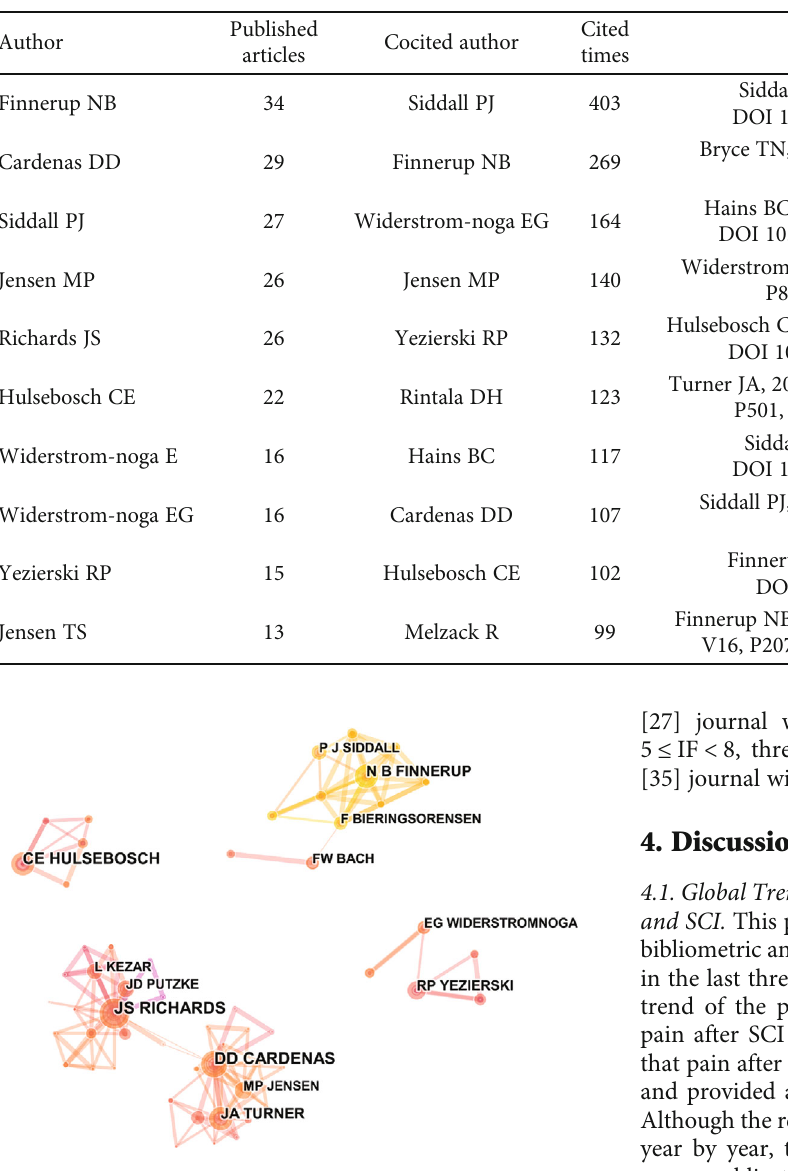
Figure 9: The analysis of authors. Network map of active authors that contributed to pain after spinal cord